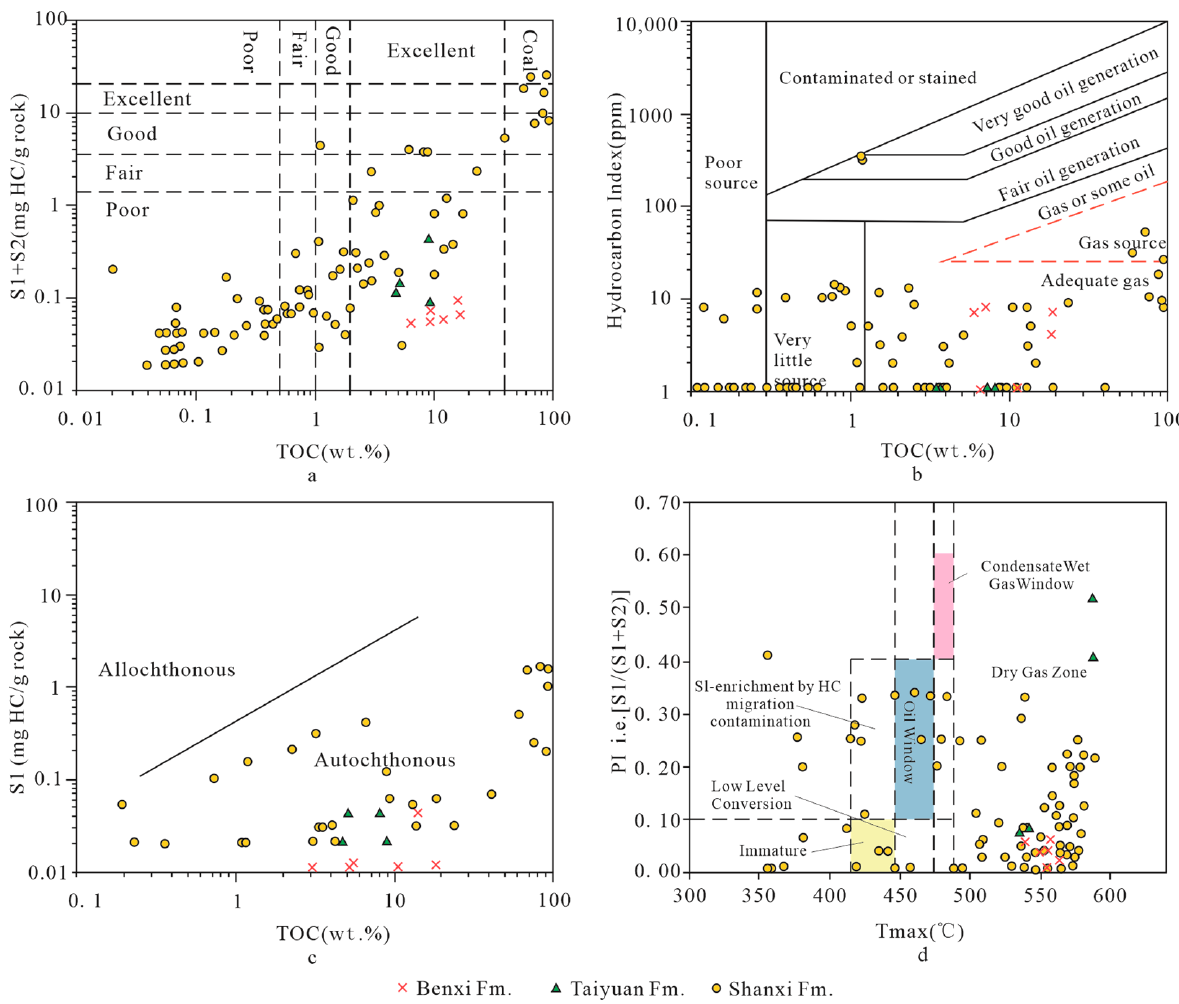
Figure 6. Cross-plots: ( a ) the wax indexes versus TOC/S1 + S2; ( b ) the wax indexes versus TOC/hydrocarbon index; ( c ) the wax indexes versus TOC/S1; ( d ) the wax indexes versus Tmax/PI [S1/(S1 + S2)].